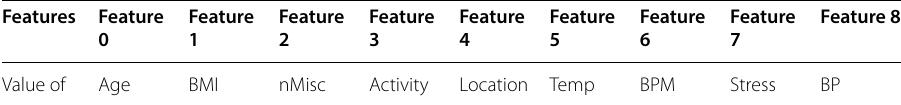
Table 10 Features meaning